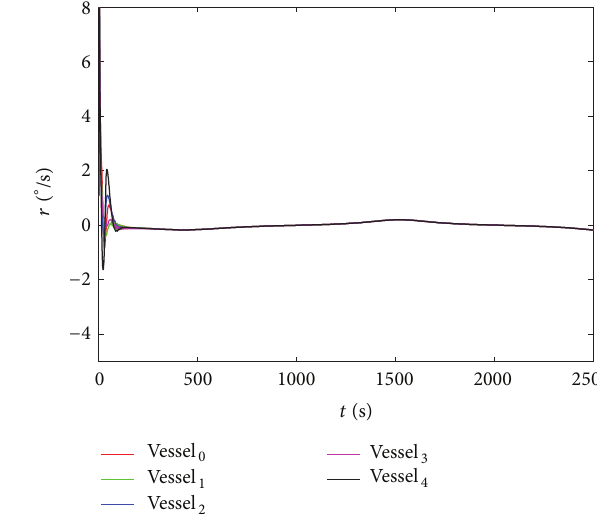
Figure 5: The sway velocities consensus of the vessels.